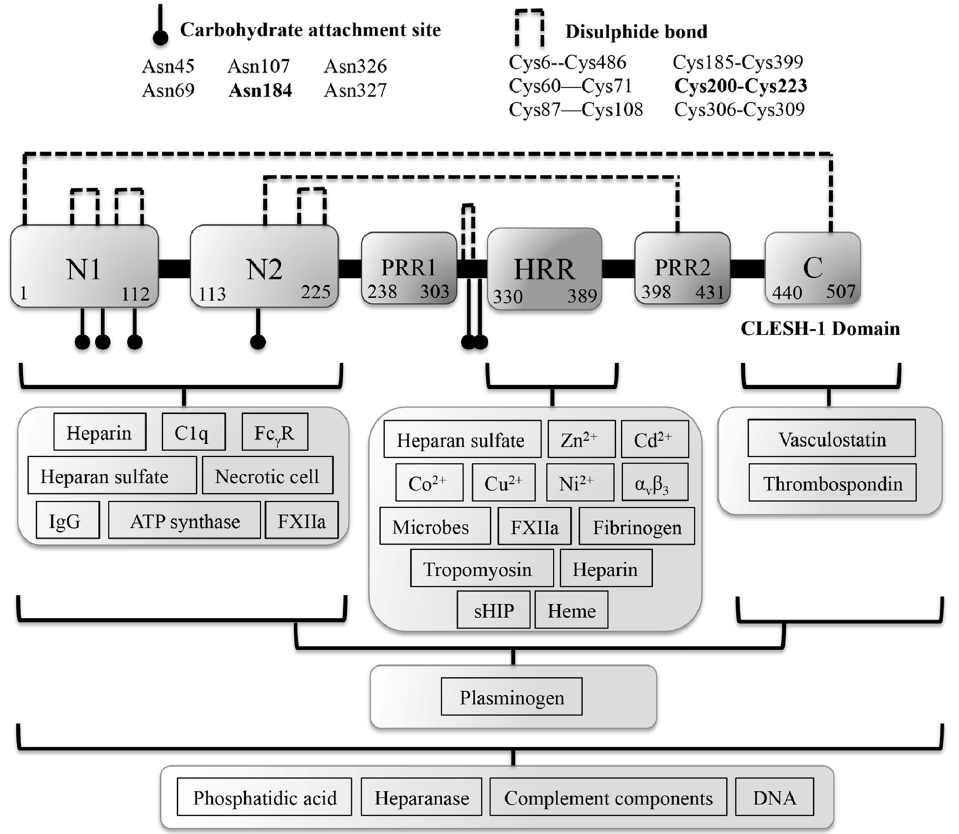
Figure 1. Domain structure and ligands of histidine-rich glycoprotein (HRG). Proposed domains of human HRG are shown with ligands listed for each domain/region based on current literature [3,13–15]. The predicted structure of HRG consists of two N-terminal cystatin homology domains (N1 and N2), a histidine-rich region (HRR) flanked by two proline-rich regions (PRR1 and PRR2) and a C-terminal domain (C). N-linked glycosylation sites and disulphide bonds are indicated in bold. The only HRG domain of known structure is the recently solved N-terminal cystatin domain 2 (N2) from rabbit,